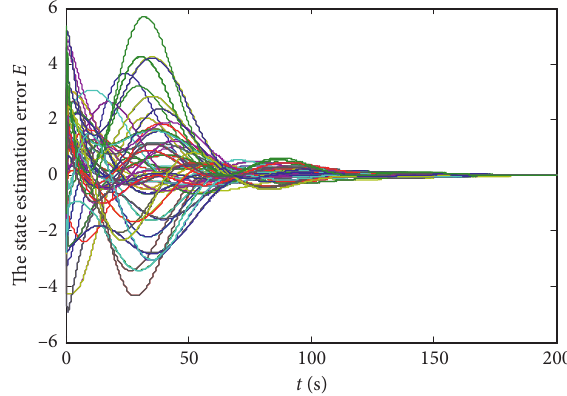
Figure 4: The response curves of the estimation error matrix E